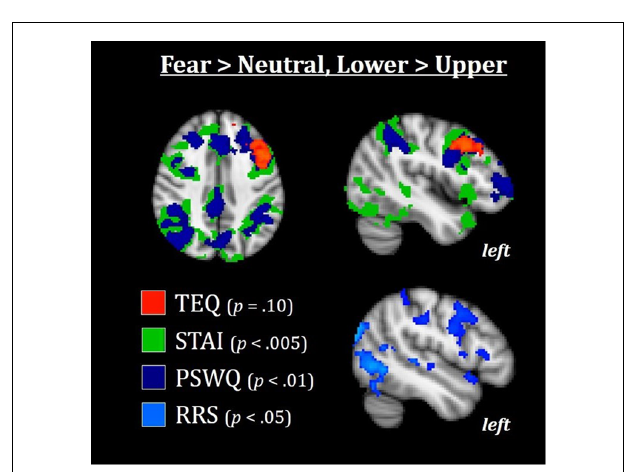
FIGURE 7 | Median splits of TEQ, STAI, PSWQ, and RRS total revealed that the Lower halves of these traits were associated with enhanced activations in the frontoparietal attention network, with TEQ exhibiting one overlapping but non-significant cluster in the left dlPFC. This increased top-down activation for individuals in the Lower halves of these traits may facilitate switching between emotional and non-emotional states. All results are FWE-corrected. TEQ, Toronto Empathy Questionnaire; STAI, State-Trait Anxiety Inventory; PSWQ, Penn State Worry Questionnaire; RRS, Ruminative Responses Scale; dlPFC, dorsolateral prefrontal